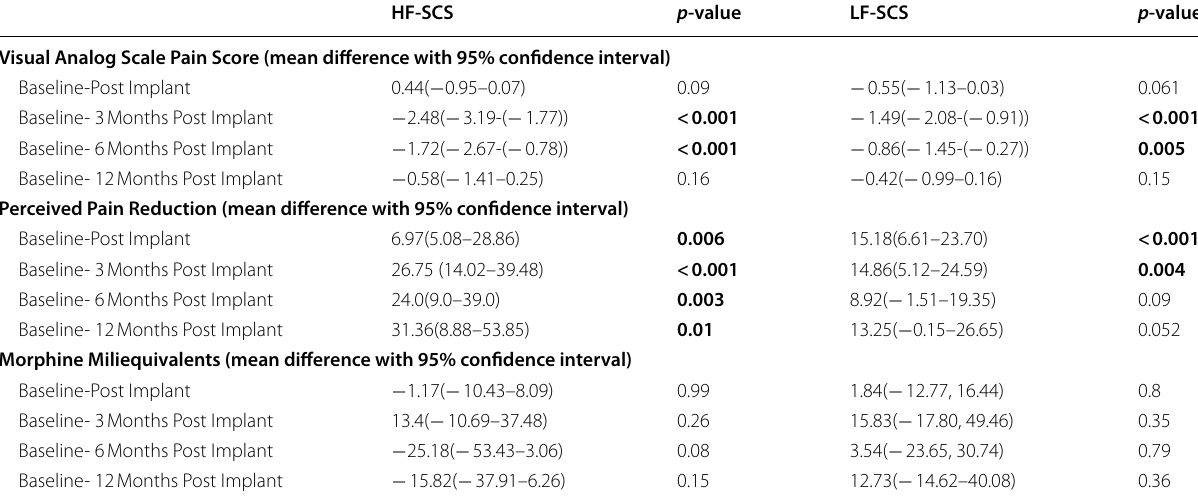
Table 3 Comparison of high frequency and low frequency spinal cord stimulator mean differences and 95% confidence intervals at each time point for visual analog scale pain scores, perceived pain reduction and opioid use. For mean differences, the confidence interval is considered not significant if it crosses zero Visual Analog Scale Pain Score (mean difference with 95% confidence interval)